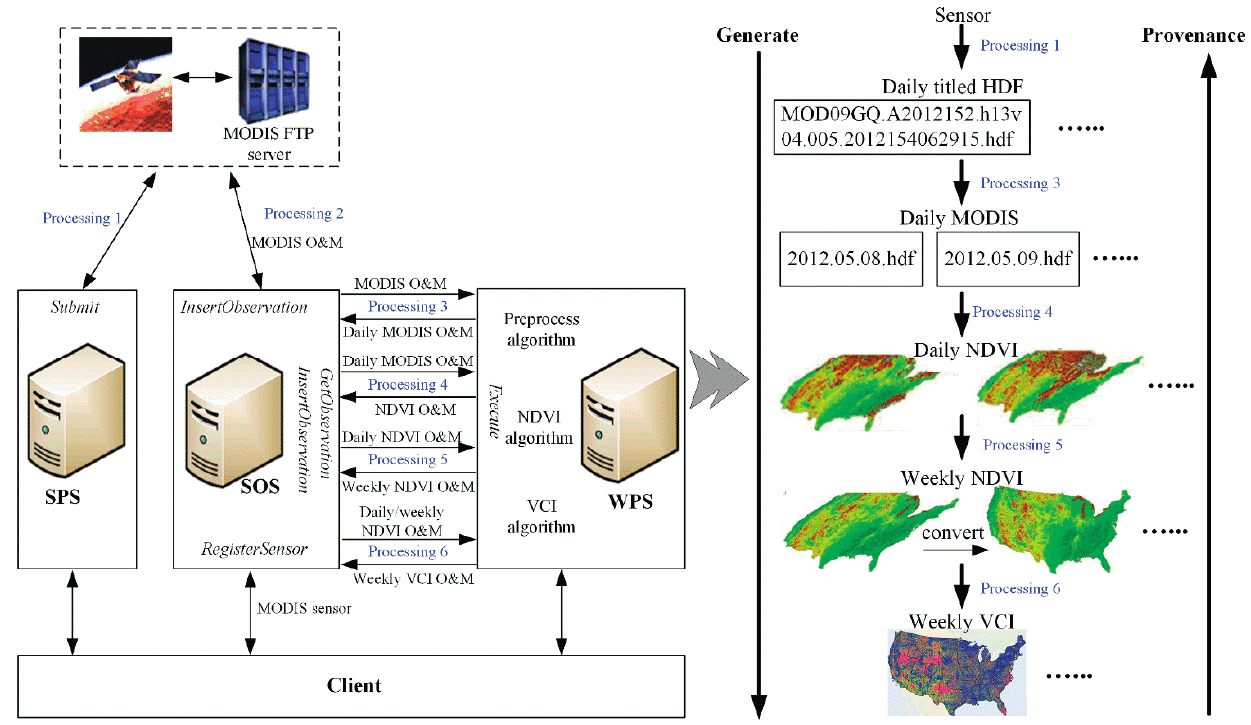
Figure 8. Six processing of the